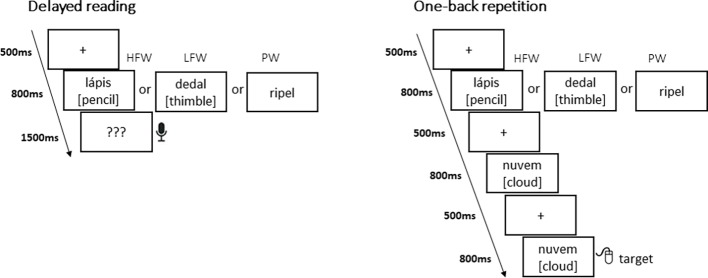
Examples of stimuli and presentation sequences in the delayed reading task and in the one-back repetition task (50 items were presented per experimental condition in a blocked design with high-frequency words—HFW, low-frequency words—LFW, and Pseudowords—PW).